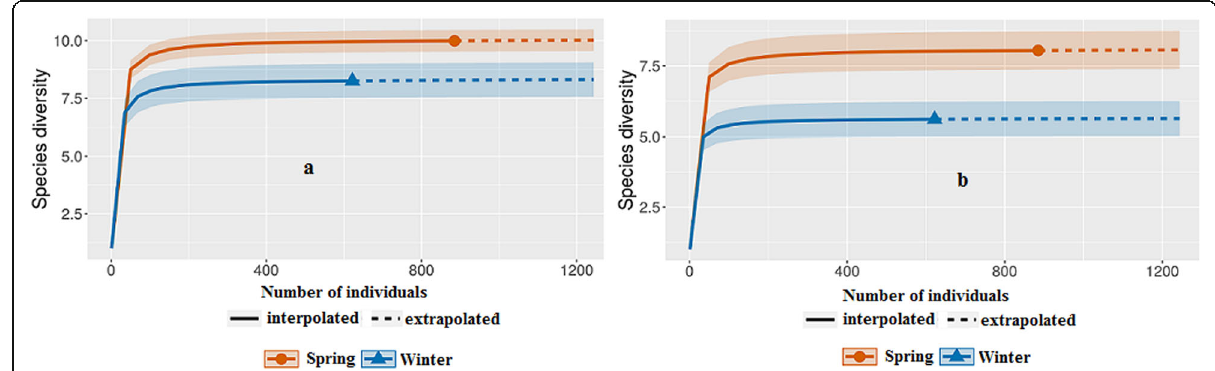
Fig. 2 Comparison of sample-size-based rarefaction (solid lines) and extrapolation (dashed lines) of insect species diversity for Shannon ( a ) and Simpson ( b ) indices between the spring and winter